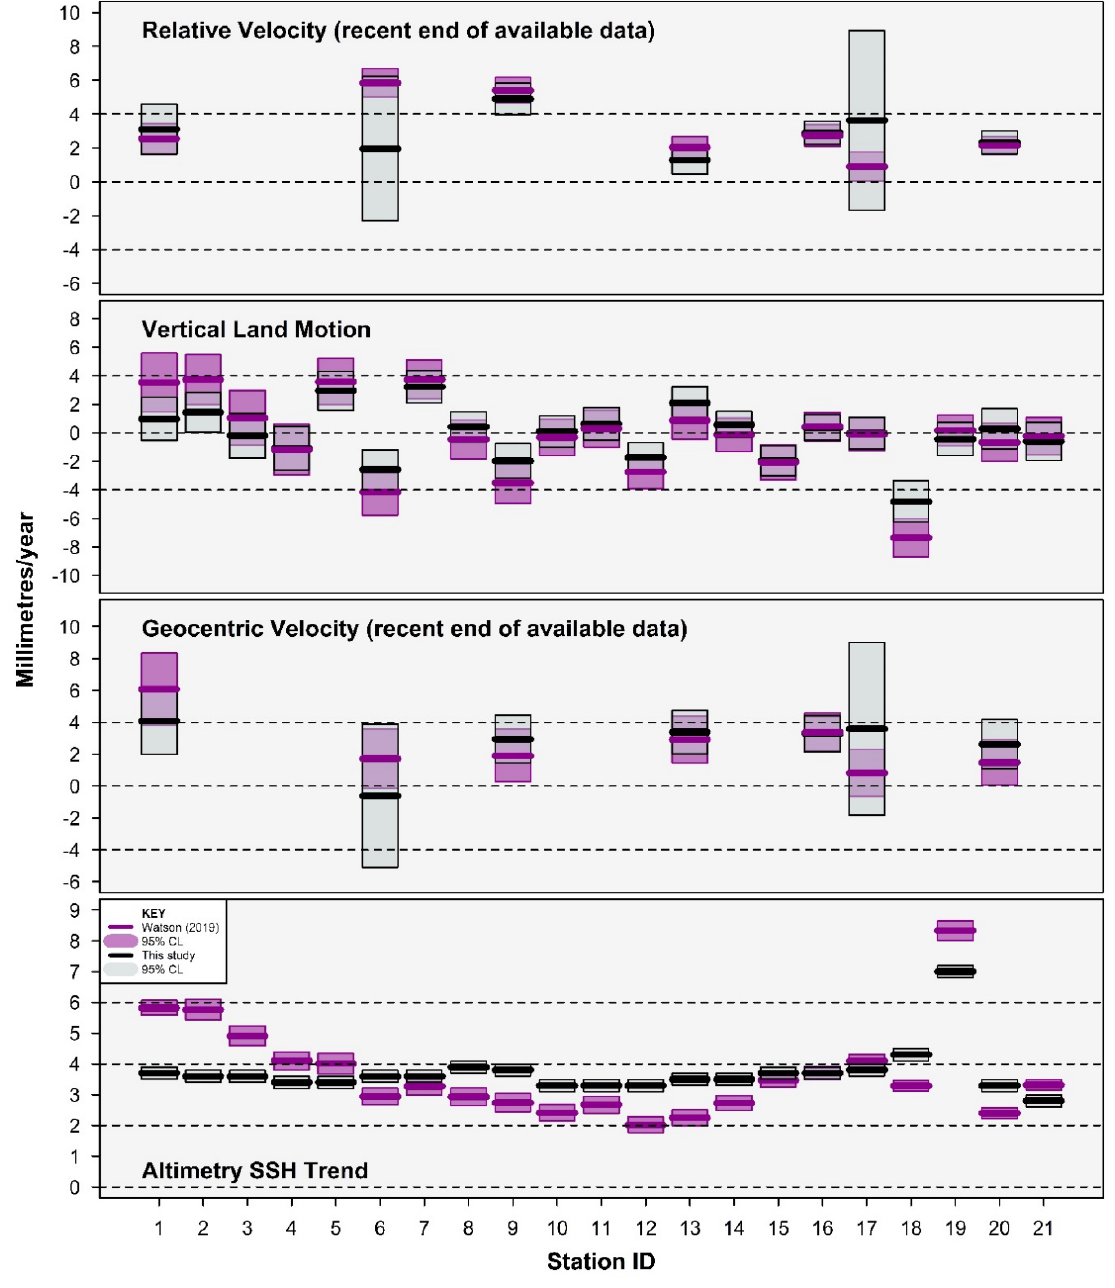
Figure 5. Comparison between the results of Watson (2019) [5] and the current study. Refer to Figure 1 and Table 1 for station ID details. Shaded boxes represent 95% confidence intervals in each panel.